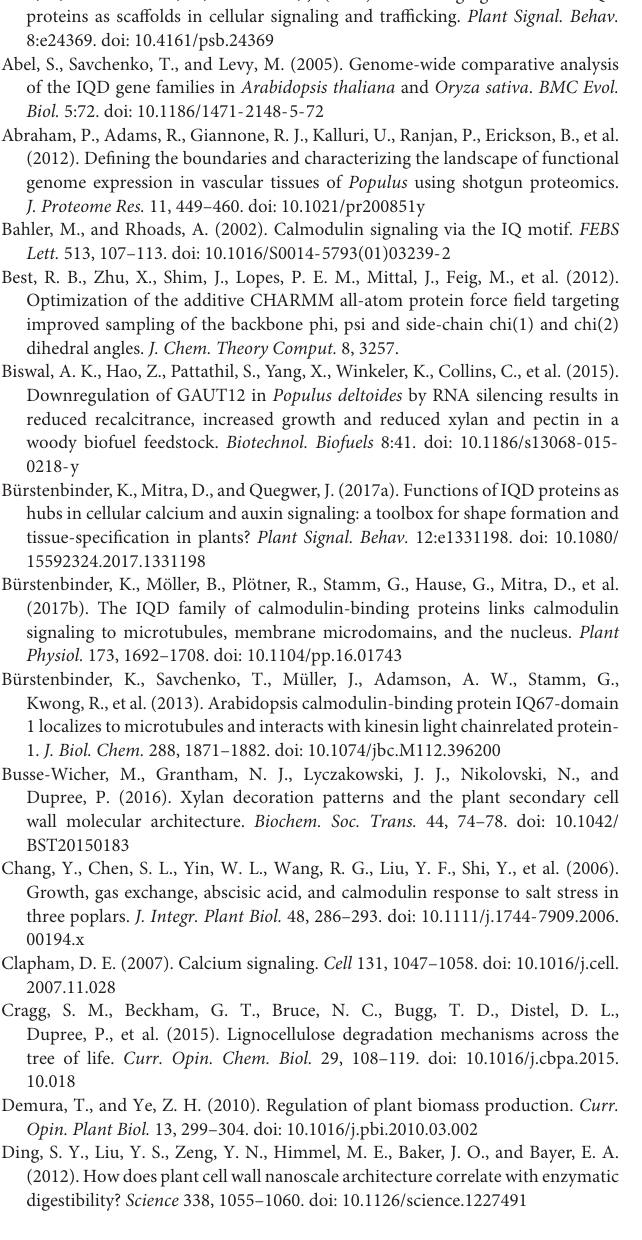
represents 36 Populus and 25 Arabidopsis calmodulin/calmodulin-like protein sequences. FIGURE S6 | Subcellular localization of CaM247 and CaM014 in Populus protoplasts. To increase accessibility of these subcellular localization images, the yellow color channel was converted to magenta uniformly across all images in the CMYK color spectrum. The original RGB color scheme images are provided in Supplementary Figure S10 . The color scheme is as follows: GFP/RFP: blue/cyan; chlorophyll, FM64 and mCherrry: red/orange. FIGURE S7 | Domain Architecture of the four Populus KLC proteins.